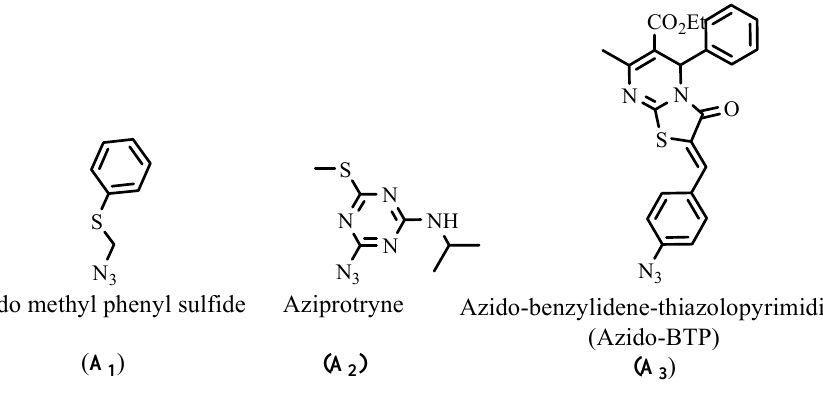
Figure 1. Structures of the three different azides used in this work.